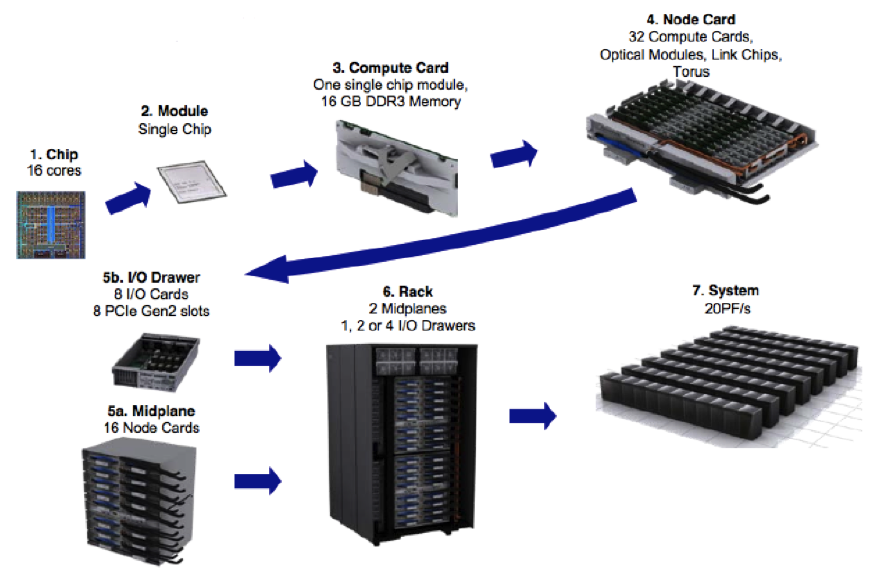
Figure 3: Blue Gene/Q packaging